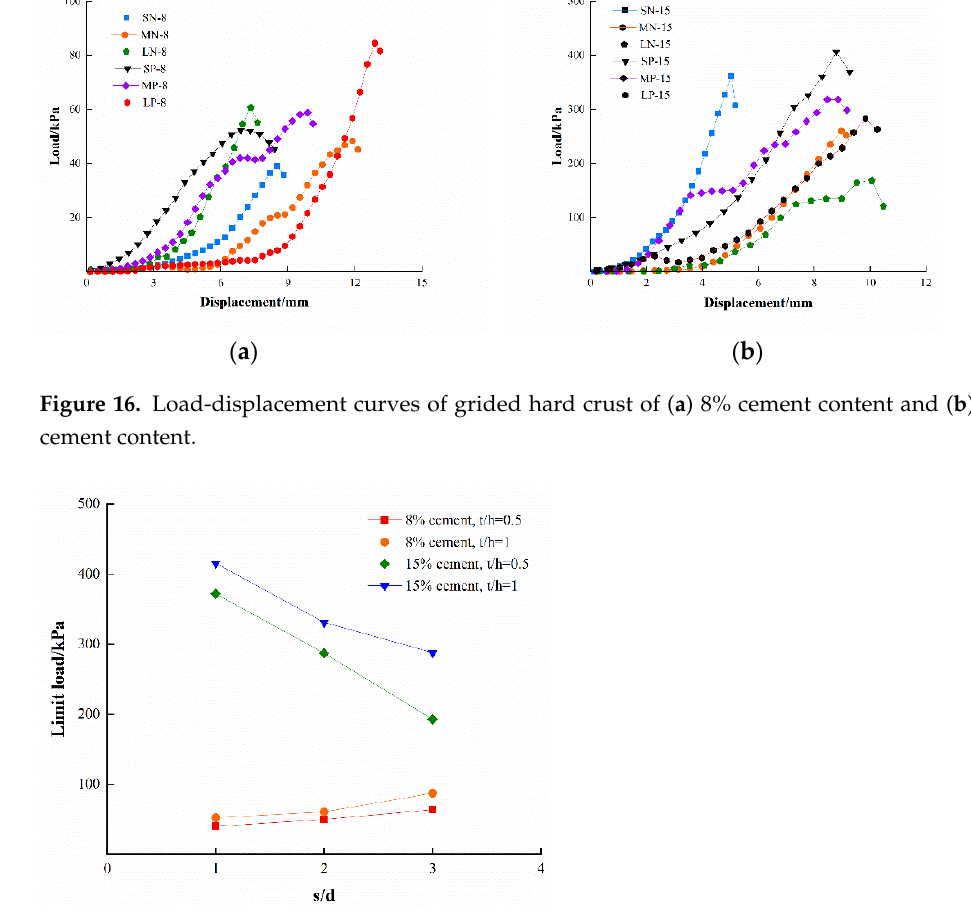
Figure 17. Relationship between ultimate load and structure of the gridded hard crust.